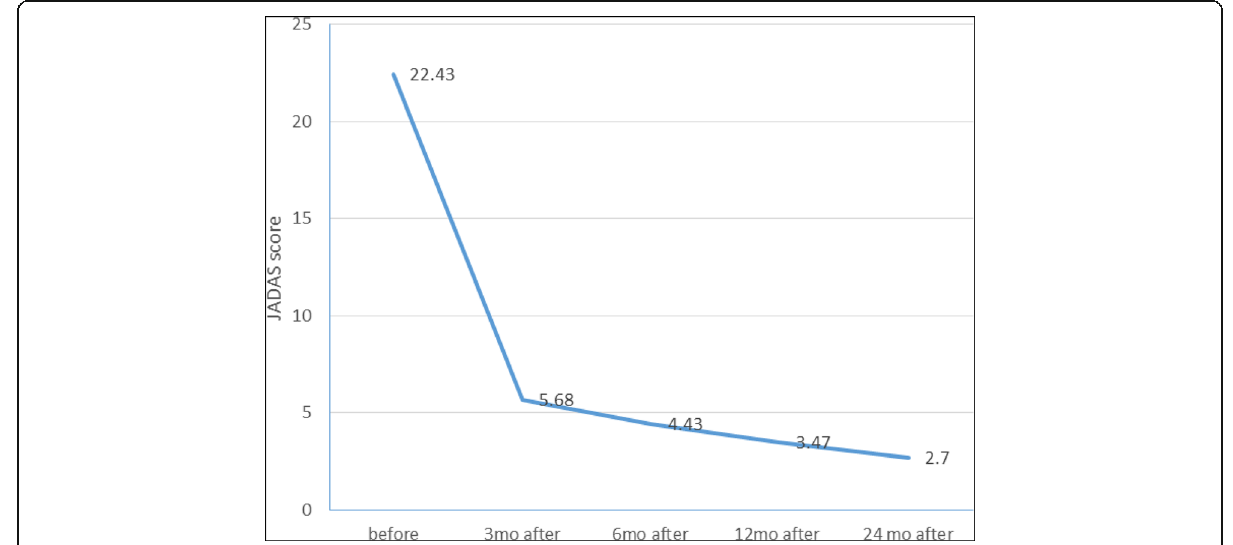
Fig. 1 Median JADAS score before initiation of TCZ, 3, 6, 12, and 24 months after its